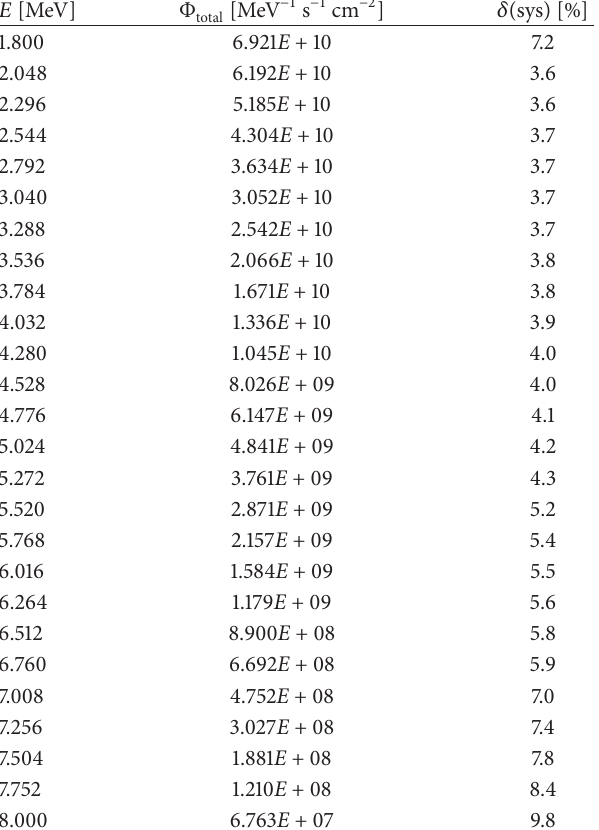
Table 4: Total antineutrino flux at day 200 for one of the reactors of the LVNPP, at 100 m from the reactor core. The last column shows the total systematic error 𝛿 (sys).